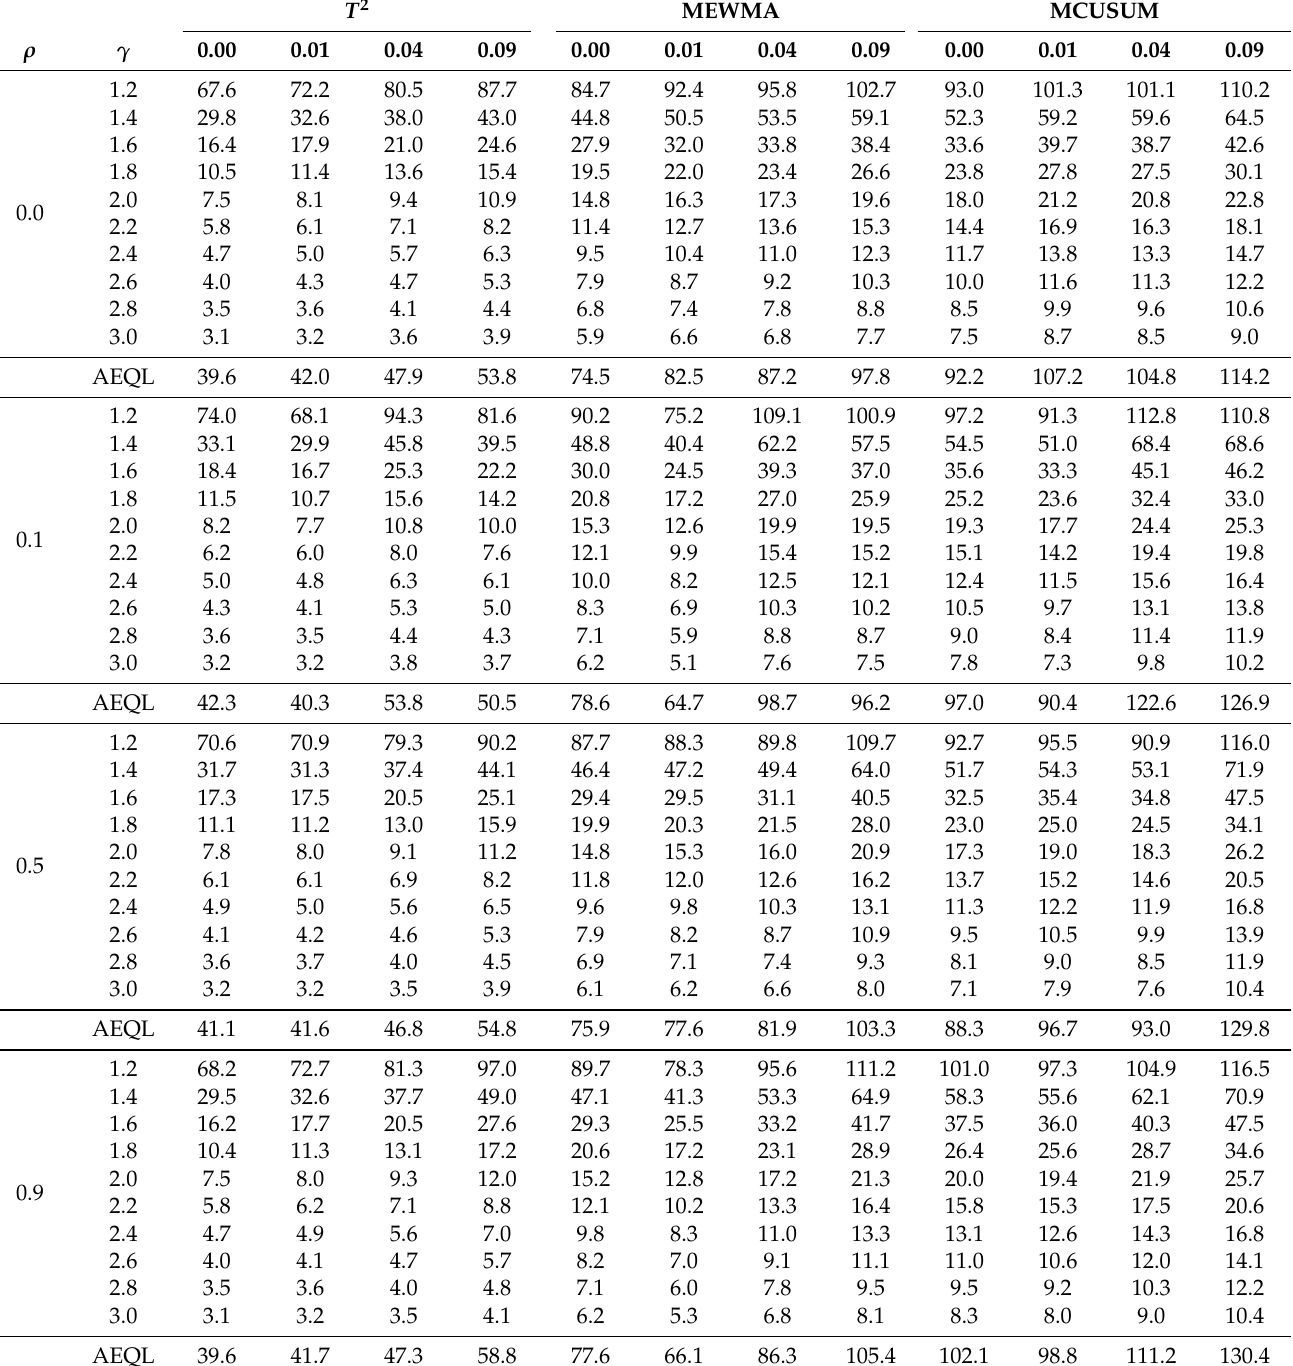
Table 4. OC ARLs of control charts for different values of σ 2 T 2 MEWMA